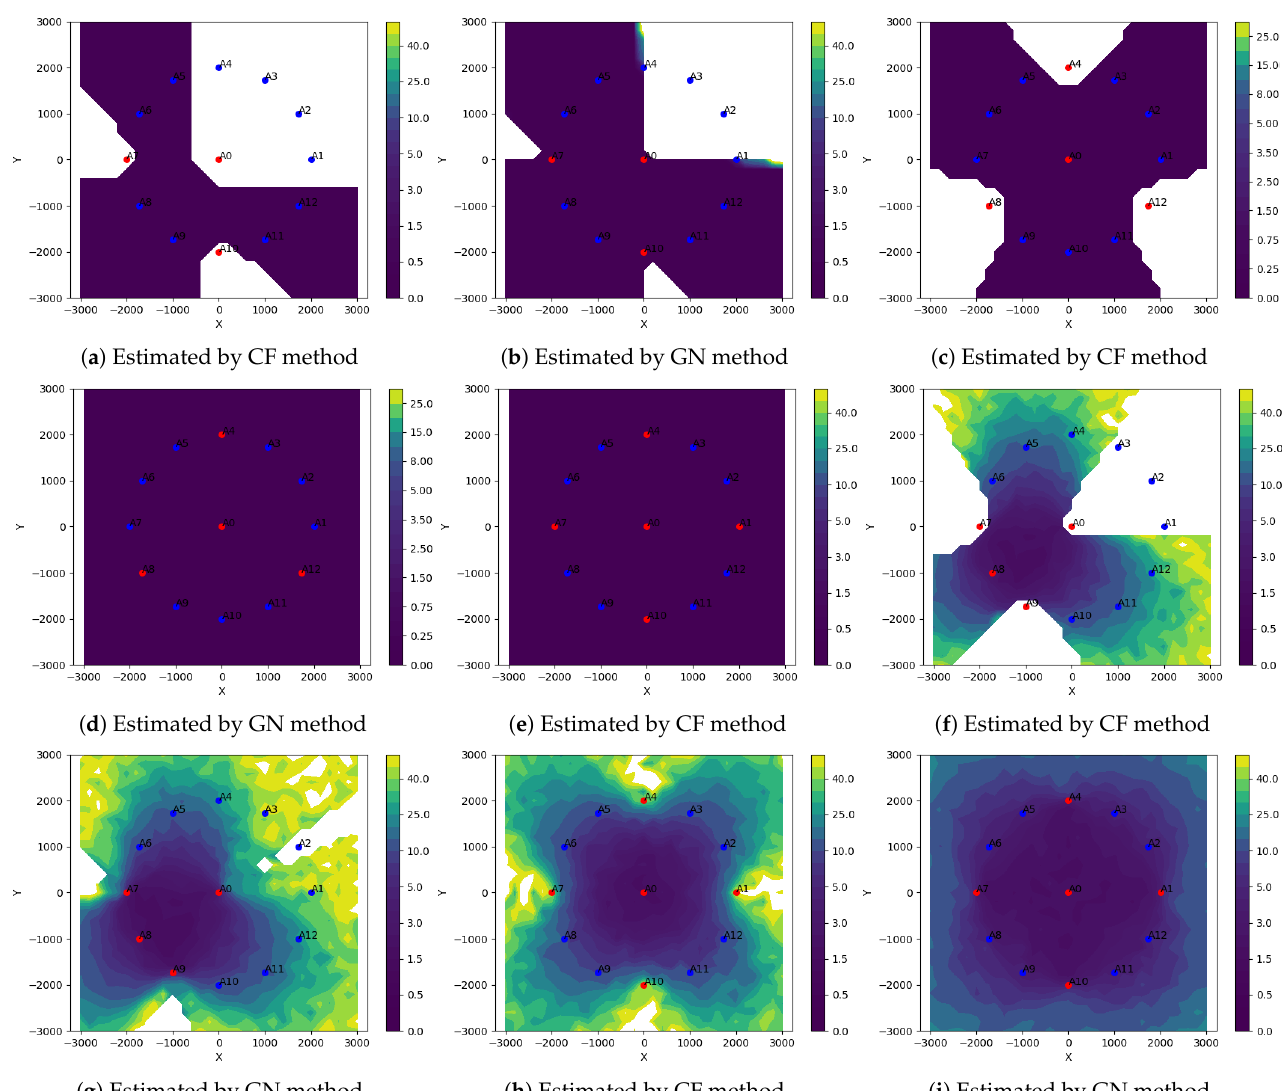
Figure 4. Comparison between the CF and the GN methods based on uniquely localizable areas. The plots show maps of mean-L2-norm-error calculated over 100 trials for each sensor located at 100 m depth on a 2D rectangular grid of size 31 × 31 over a region of 6000 × 6000 m 2 . The discs (blue and red) represent the anchors placed symmetrically on a circle with radius = 2000 m and center at origin. The red discs are the anchors which take part in TDoA measurements and the name with lowest index represents the lead anchor. Subfigures ( a – e ) show the localizable area when no noise in t i measurements, whereas subfigures ( f – i ) are due to i.i.d. Gaussian noise with σ = 1.0 ms in t i . The dark purple are regions where sensor are localized uniquely and white regions are where either the mean-L2-norm-errors are very large or no solution is found. Note that in all the simulations the sound speed is v = 1530 m/s. The plot clearly shows that GN method localizes larger area with lower errors than the CF